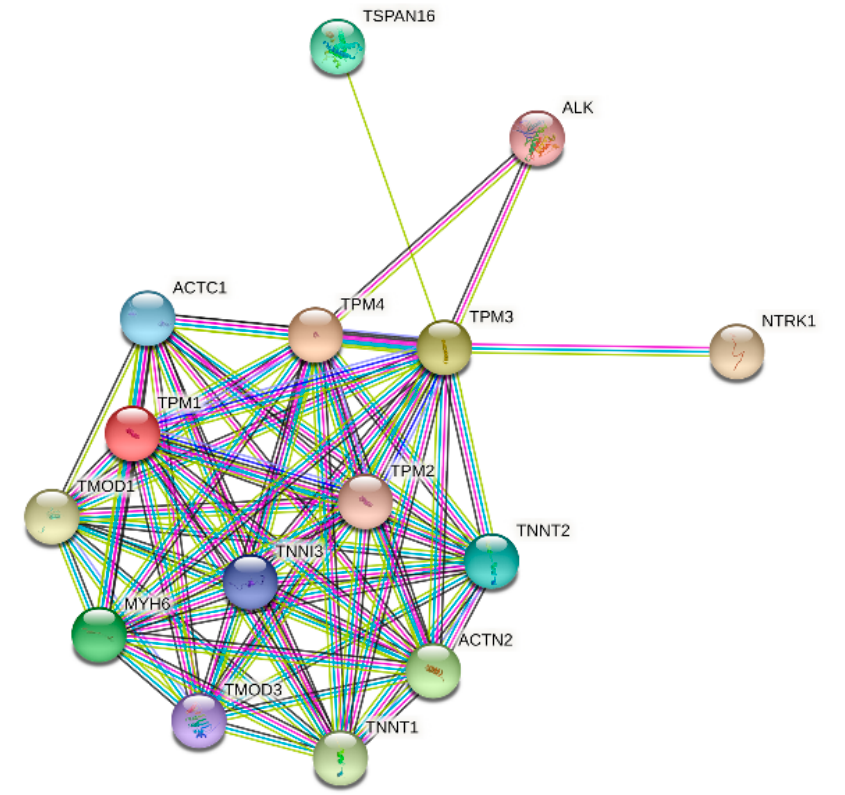
Figure 10. Protein–protein interaction (PPI) network analysis of 13 interacting proteins correlated with TPMs.